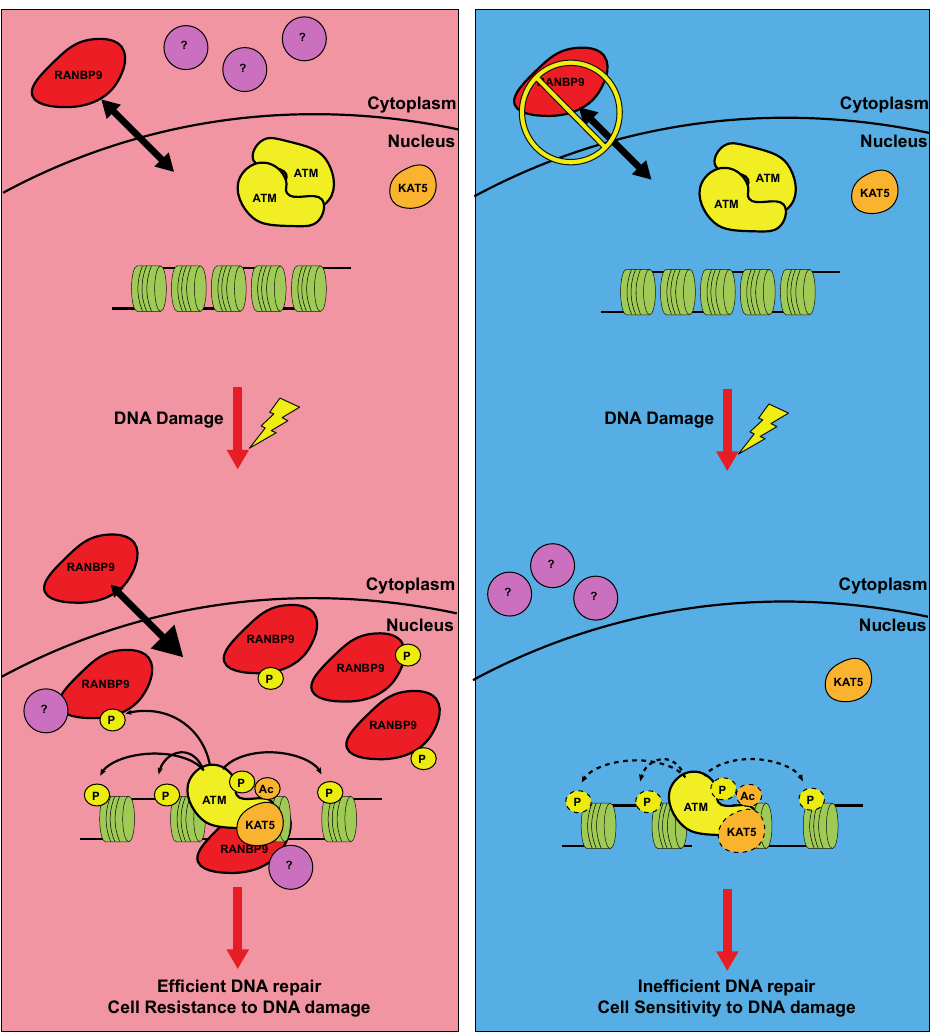
Figure 3. Potential action mechanism of RANBP9 in ATM-dependent DDR. In RANBP9 (red) expressing cells and in the absence of DNA damage (left panel, top), RANBP9 protein shuttles between the nucleus and the cytoplasm. Upon DNA damage such as IR and DNA-damaging drugs (left panel, bottom), ATM is activated and enhances RANBP9 nuclear accumulation through its phosphorylation, potentially with other cytoplasmic partners (purple). This event potentially leads to enhanced KAT5-dependent ATM acetylation, a marker of its full activation. For this reason, RANBP9-expressing cells activate an efficient ATM signaling pathway, resulting in efficient DNA repair and survival to genotoxic stress. Conversely, when RANBP9 expression is reduced, the full activation of ATM is impaired, leading to inefficient DNA repair and sensitivity to DNA damaging agents.